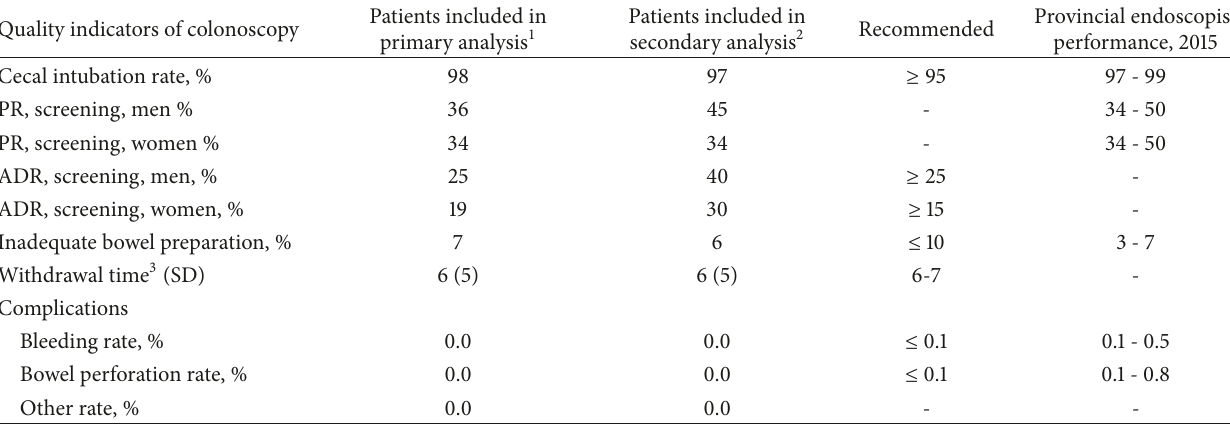
Table 4: Quality indicators and complication rates as supported by a work group for the Cancer Care Ontario, and 2015 reported endoscopist performance statistics compared to this independent health facility (IHF)